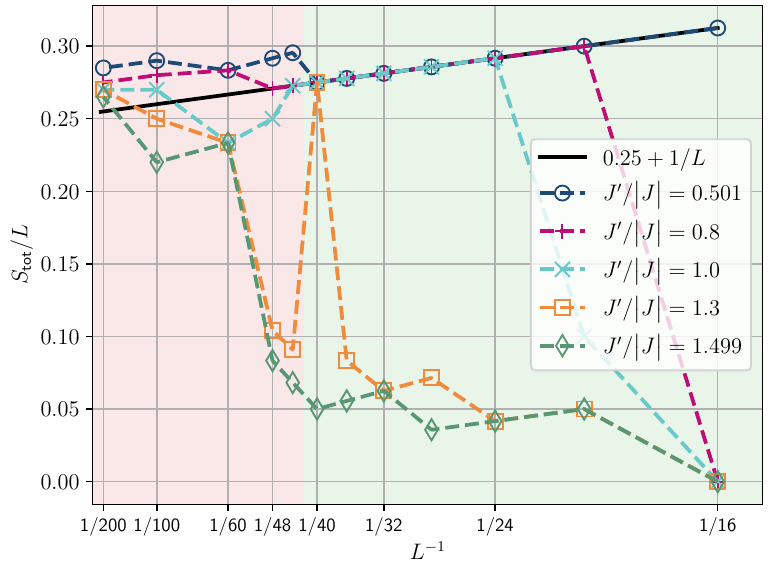
Figure 3: Total ground-state spin per site S riodic boundary conditions. For L ≤ 36, the results were obtained using exact di- agonalization (Lanczos algorithm). For the other values, we used the DMRG with SU(2) symmetries and identified the true ground state from the minimum of E similarly to Fig. 2. FM and FiM denote the ferromagnetic and ferrimagnetic phase, respectively.